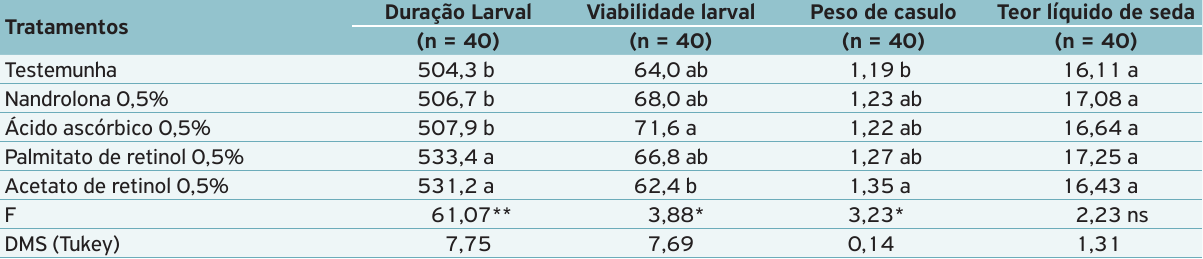
Tabela 3. Duração larval (h), viabilidade larval (%), peso de casulo (g) e teor líquido de seda (%) de Bombyx mori alimentado com folhas de amoreira contendo diferentes aditivos aplicados por imersão.